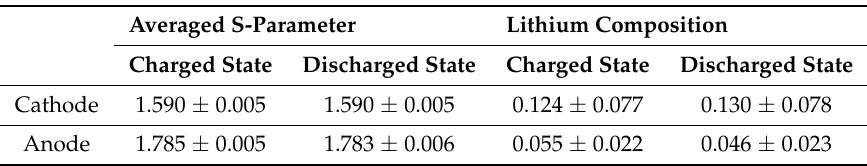
Figure 4. In the aged cell: ( a ) The Compton scattering intensity distribution in the charged state. ( b ) The Compton scattering intensity distribution in the discharged state. ( c ) The S-parameter distribution in the charged state. ( d ) The S-parameter distribution in the discharged state. Table 2. The averaged S-parameter and corresponding lithium composition in the charged and discharged states in the aged